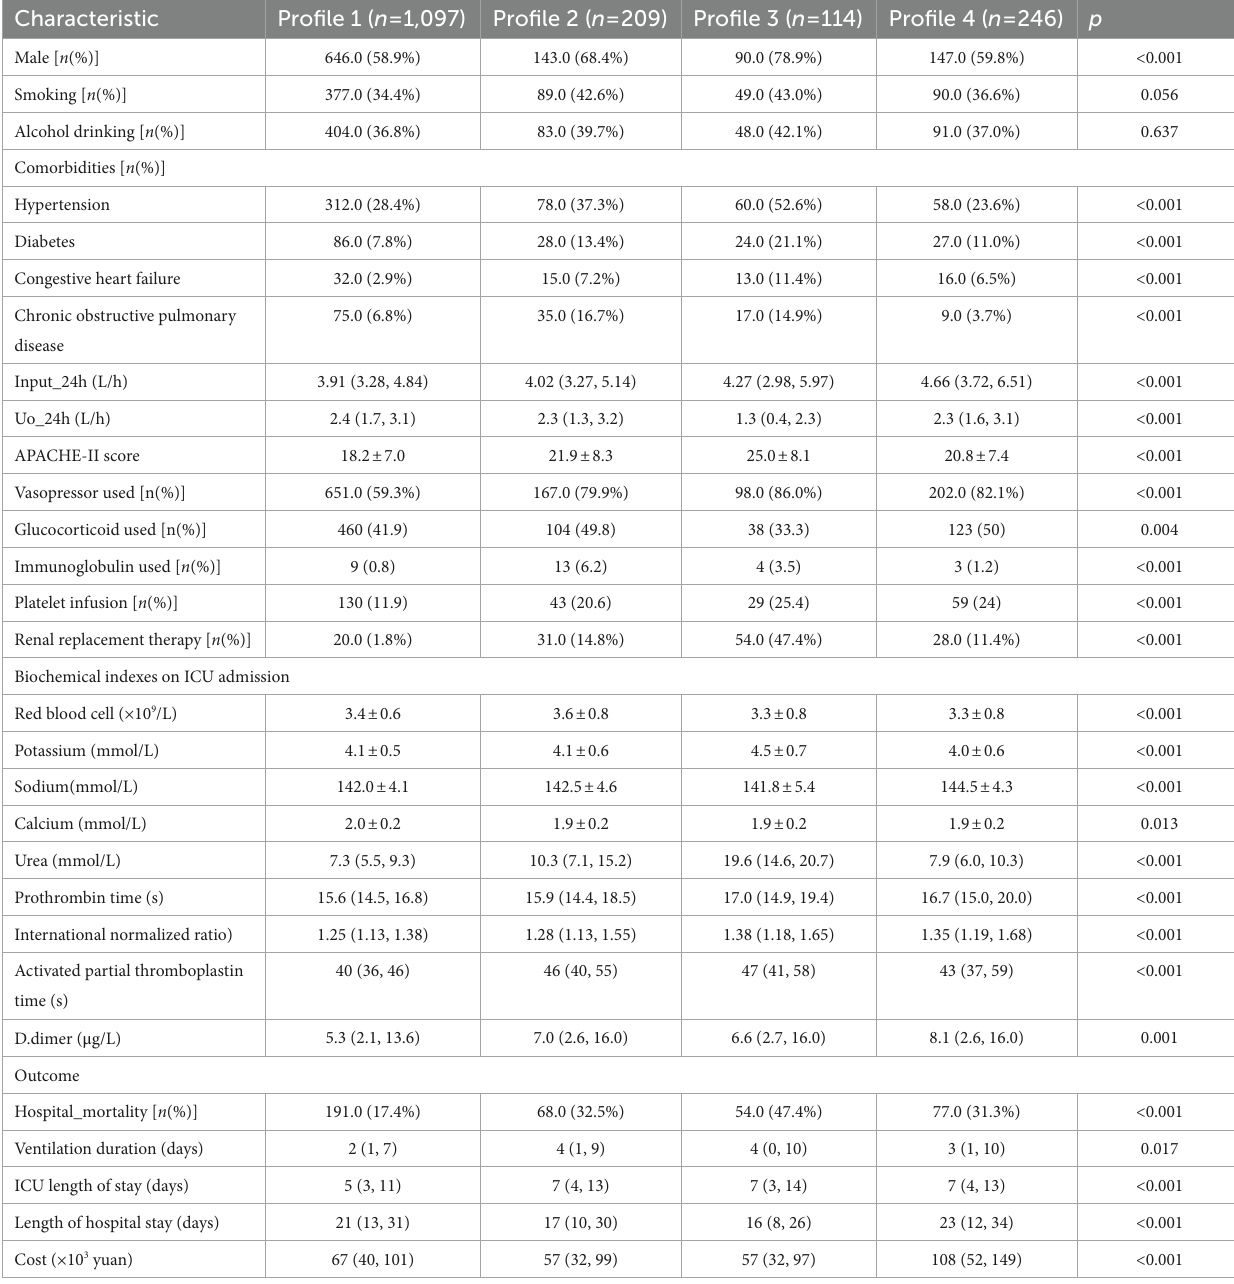
TABLE 2 Categorical variables and outcome variables not included in the mixture modeling.